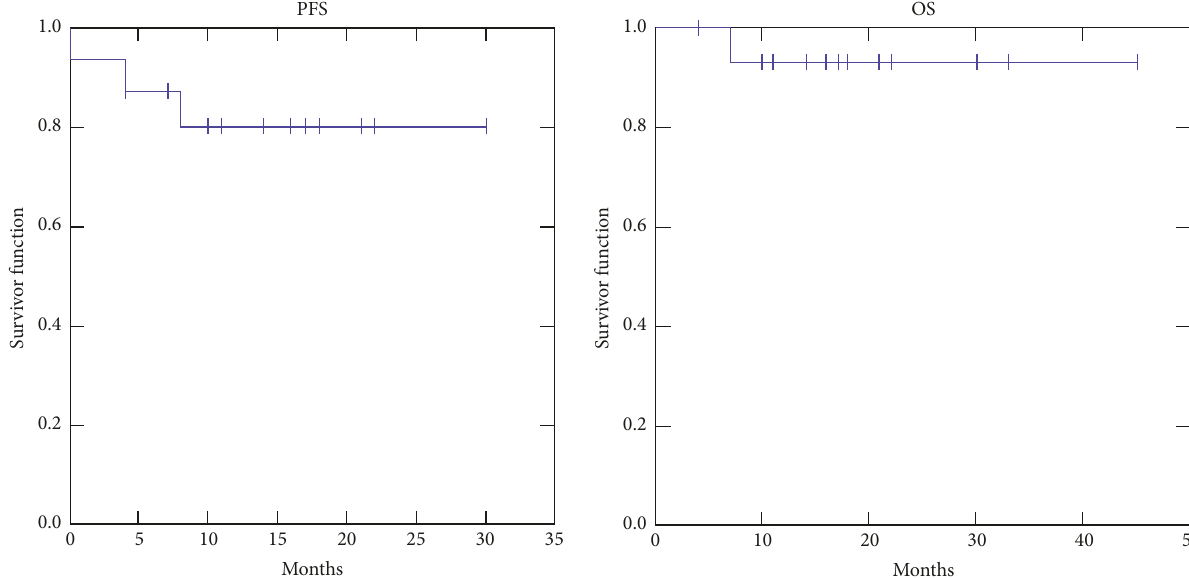
Figure 2: Actuarial progression-free survival (PFS) and actuarial overall survival (OS).